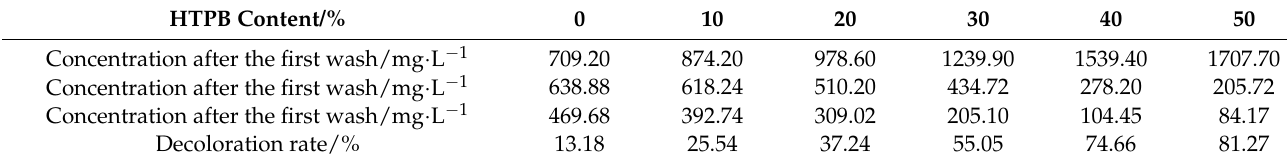
Table 10. Concentration of residual dye after the third Table 7. Concentration of residual dye after the first reduction cleaning.